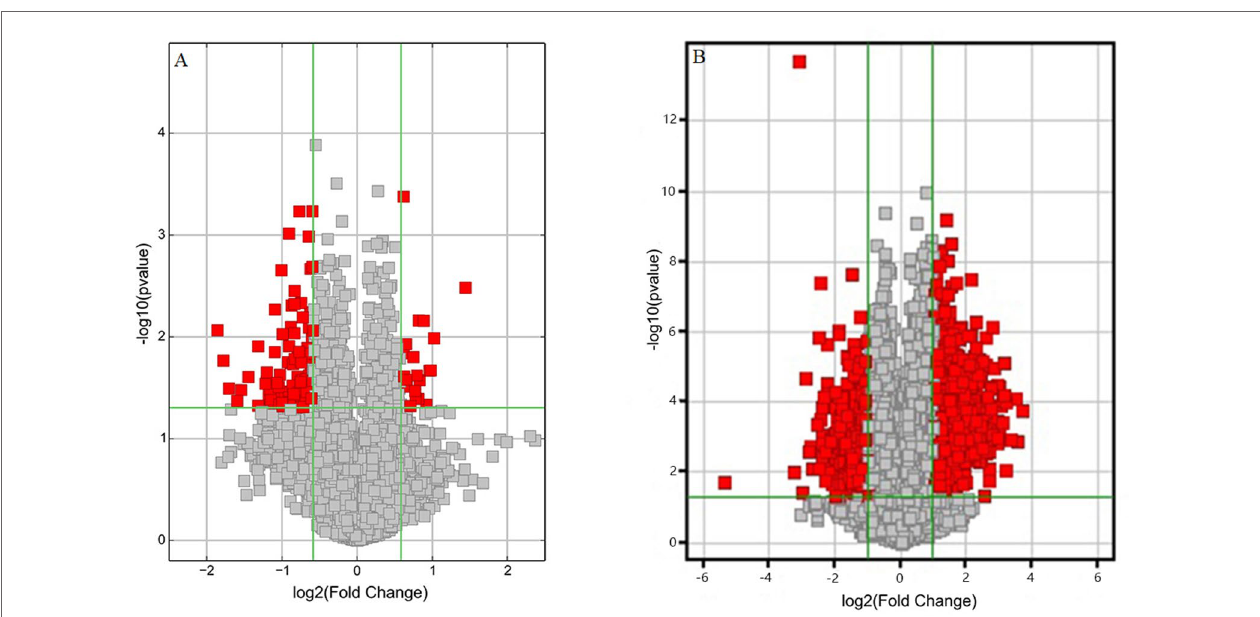
FIGURE 3 | Volcano plots of differentially expressed (A) circRNAs and (B) mRNAs. Red points represent the differentially expressed circRNAs/mRNAs with statistical significance (Fold change > 1.5 and P < 0.05). Log2 (Fold change) < 0, downregulated transcripts; log2 (Fold change) > 0, upregulated